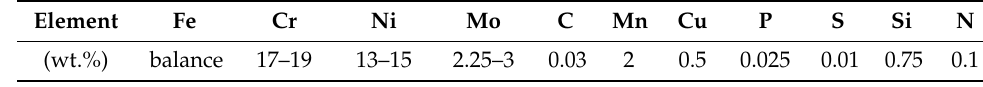
Table 1. Nominal chemical composition of studied 316L variant [33].